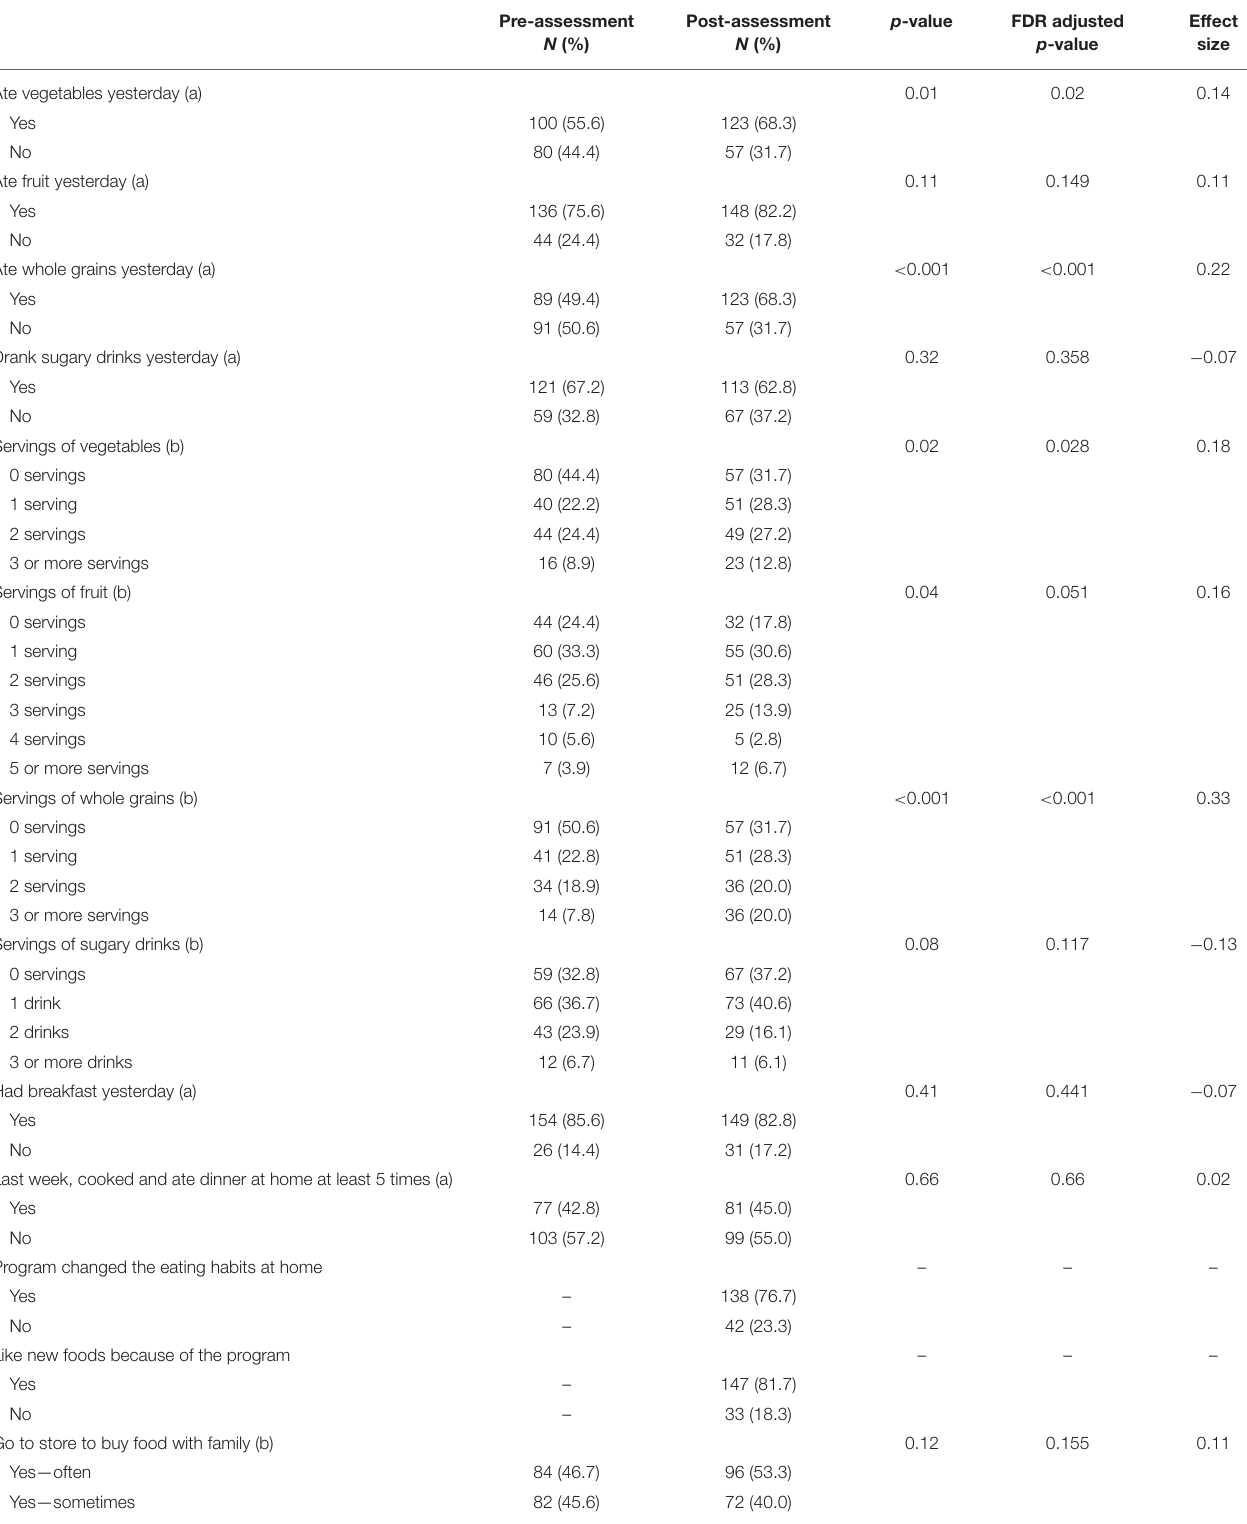
TABLE 2 | Changes in eating behaviors in children who completed both pre- and post-assessment surveys ( n = 180).